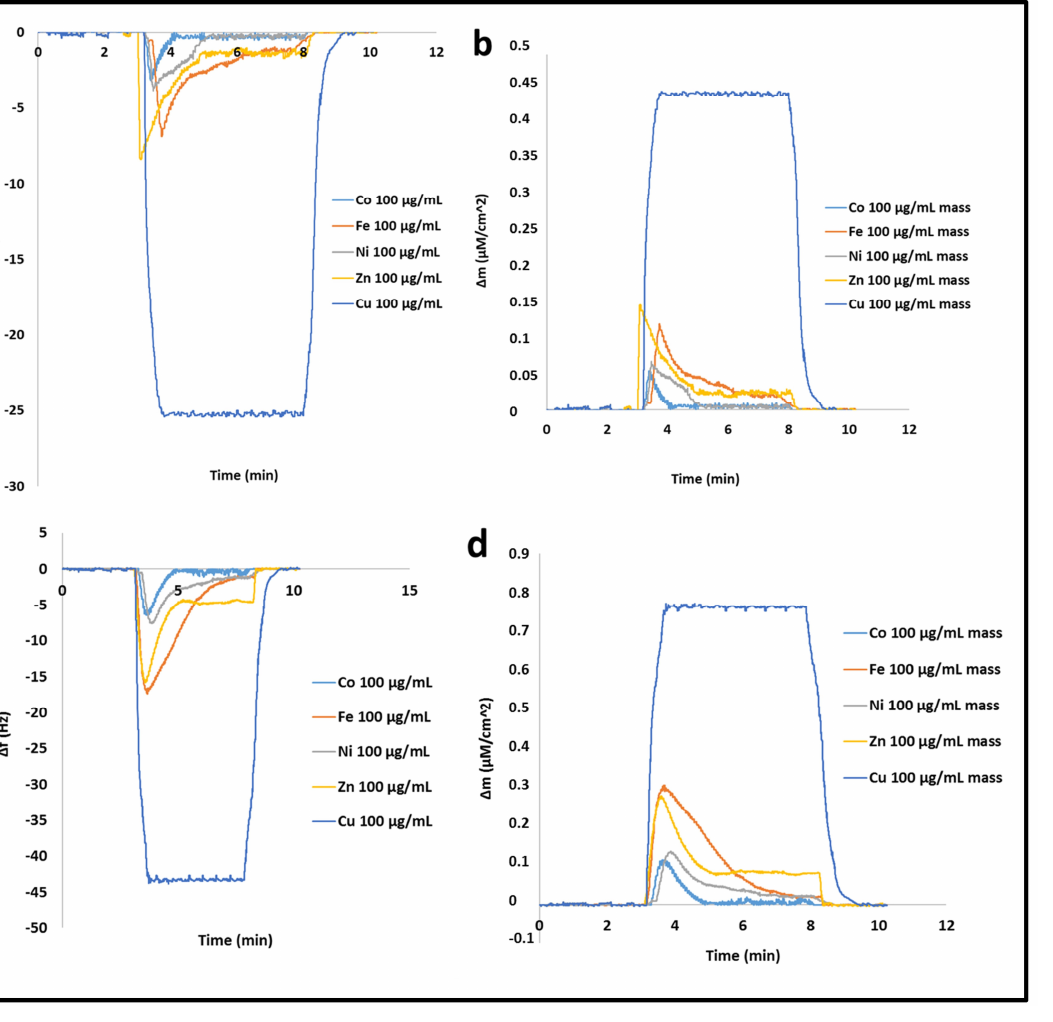
Figure 8. Sensograms of Cu(II)-MIP1 QCM nanosensor for time-dependent oscillation frequency change ( a ) and mass difference ( b ), as well as Cu(II)-MIP2 QCM nanosensor for time-dependent oscillation frequency change ( c ) and mass difference ( d ), for different